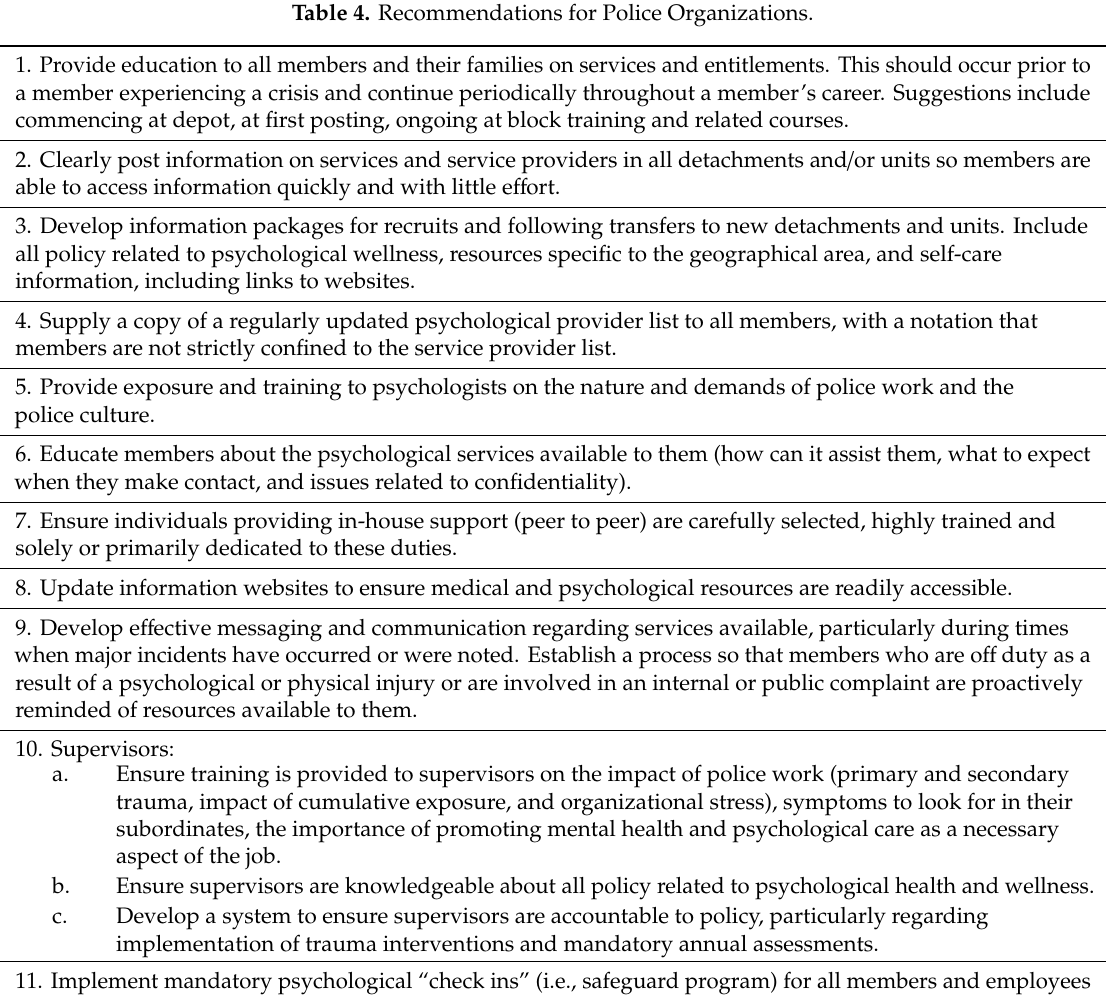
Table 4. Recommendations for Police